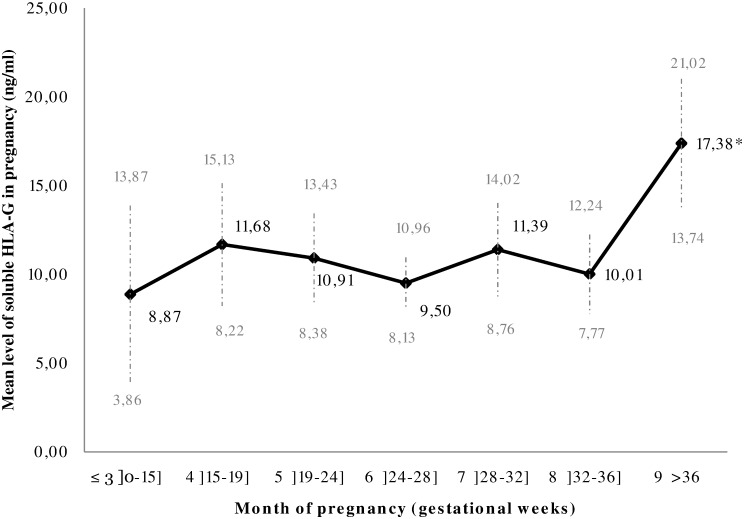
Evolution of the mean level (and 95 confidence intervals) of soluble HLA-G during pregnancy.(*) indicates that the level of sHLA-G is significantly higher at delivery (p<0.001; Kruskal-Wallis test). (≤3 months: n = 26, SD: 12.39, 4 months: n = 65, SD: 13.92, 5 months: n = 177, SD: 17.01, 6 months: n = 254, SD: 11.48, 7 months: n = 131, SD: 15.20, 8 months: n = 115, SD: 12.09, 9 months: n = 360, SD: 35.11).